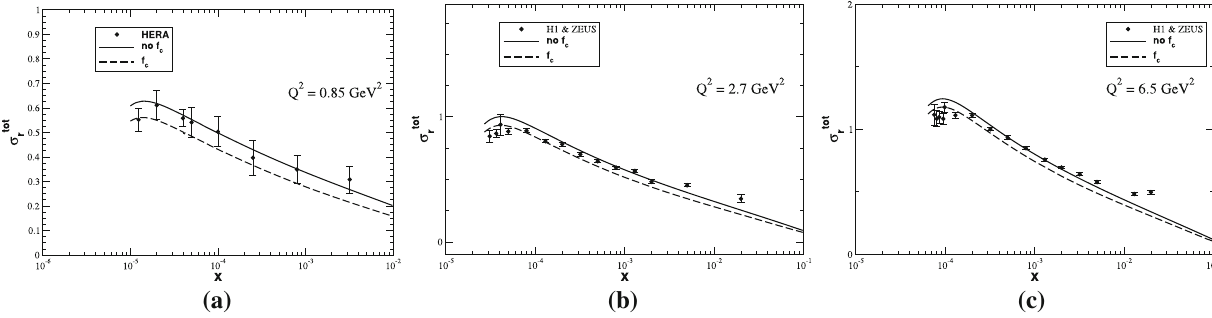
indicate that one important next step is to perform a